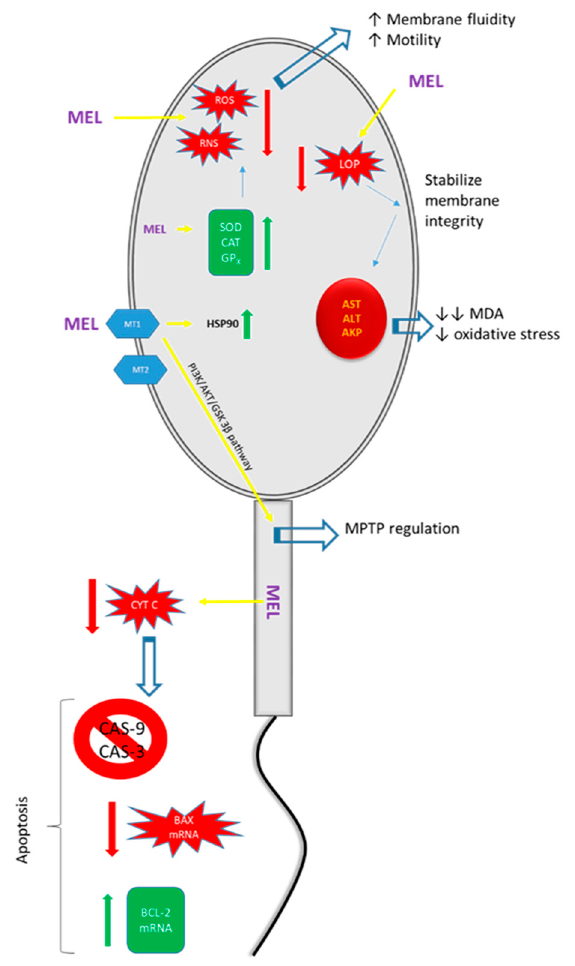
Figure 1. Illustration of the positive effects of melatonin (MEL) on spermatozoa. MT1: melatonin type 1 receptor; MT2: melatonin type 2 receptor; ROS: reactive oxygen species; RNS: reactive nitro- gen species; LOP: lipid peroxidation; SOD: superoxide dismutase; CAT: catalase; GP X : glutathione peroxidase; HSP90: heat shock protein 90; AST: aspartate amino transferase; ALT: alanine amino- transferase; AKP: alkaline phosphatase; MDA: malondialdehyde; MPTP: mitochondrial permeability transition pore.